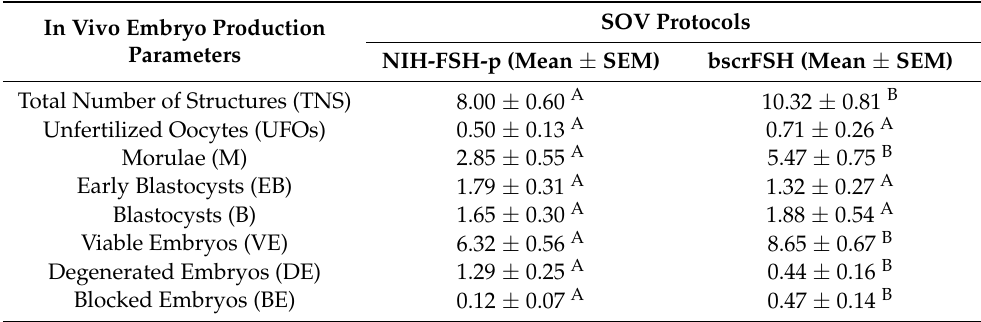
Table 4. In vivo produced bovine embryos by using different superovulation (SOV) protocols in- cluding the standard pig pituitary-derived FSH (NIH-FSH-p) and the extra-long-acting single-chain bovine follicle-stimulating hormone (bscrFSH). SOV Protocols In Vivo Embryo Production Parameters NIH-FSH-p (Mean ± SEM) bscrFSH (Mean ± SEM) Total Number of Structures